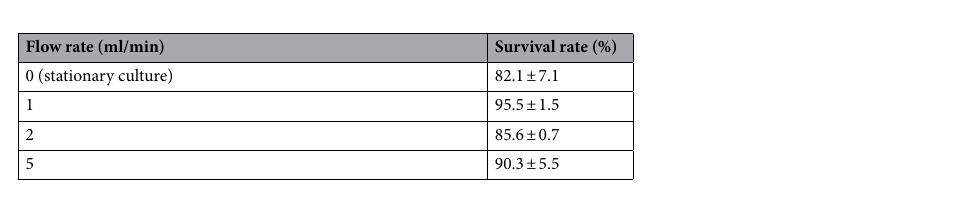
Table 2. Survival rate after bioreactor training at each flow rate defined by TUNEL staining. p > 0.05 by One- way ANOVA with an alpha level of